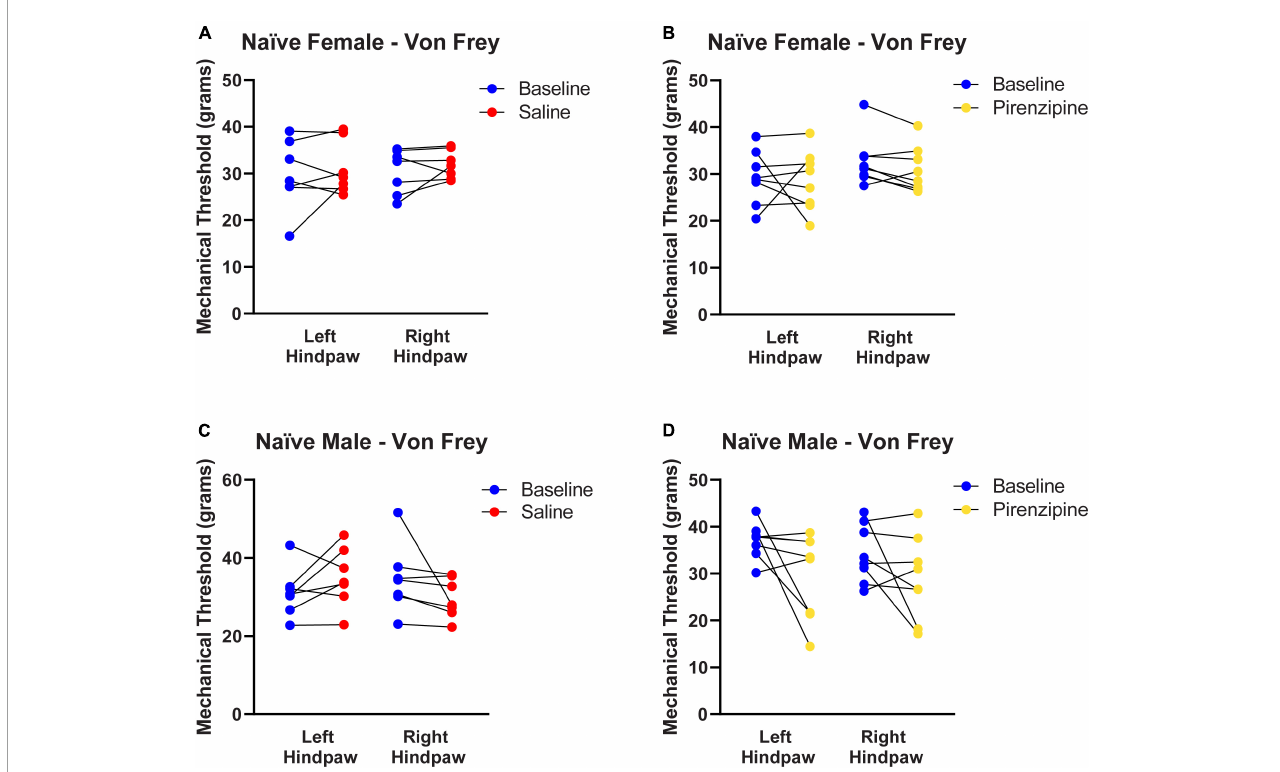
FIGURE6 Selective pharmacological M1 blockade does not induce mechanical allodynia. Control (A,C) and experimental (B,D) animals were each tested for baseline thresholds (blue symbols). They were then infused with 1 µ l of either saline (red symbols) or pirenzepine (yellow symbols) and re-tested 30 min after infusion. Pirenzepine did not have any significant on mechanical allodynia. Statistical analysis using paired t -tests yielded the following p -values: Female Saline: LP = 0.5140, RP = 0.3214 ( n = 7). Female pirenzepine: LP = 0.7905, RP = 0.1114 ( n = 8). Male Saline: LP = 0.1990, RP = 0.1666 ( n = 7). Male pirenzepine: LP = 0.0901, RP = 0.1799 ( n = 8). These are the same animal cohorts as in Figure 5 . Data points are aligned in a single file fashion. Consequently, dots with similar value are